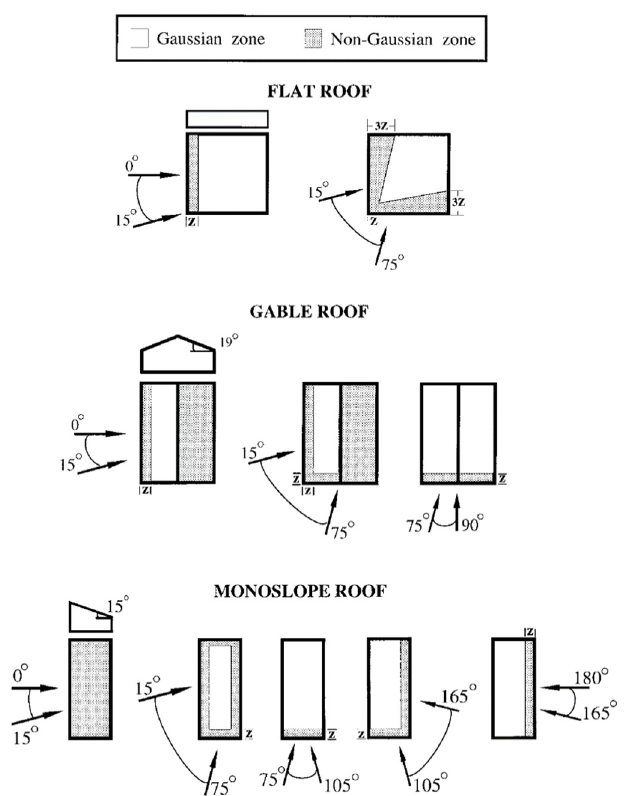
Figure 1. Gaussian and non-Gaussian zones for flat, gable, and mono-slope roofs. [1].